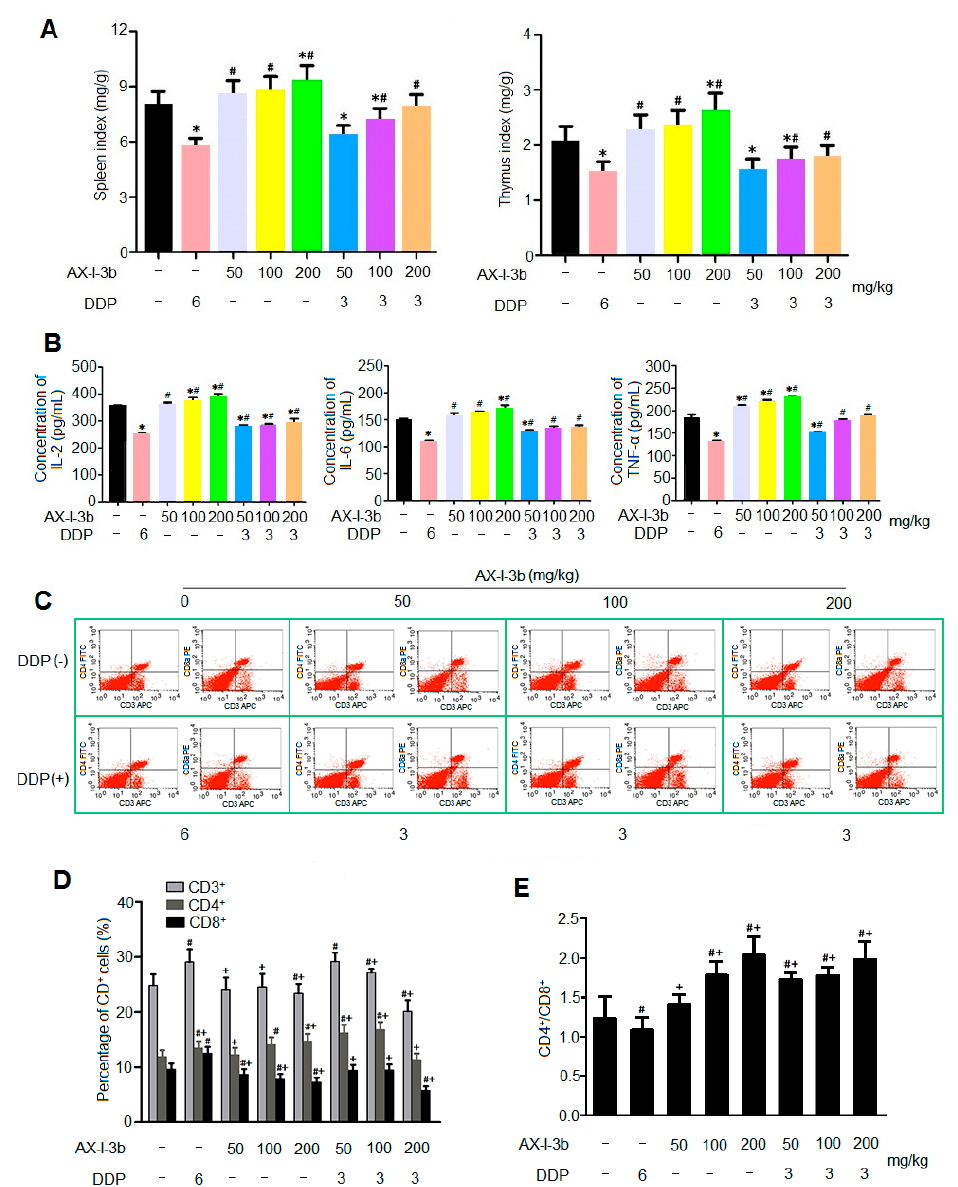
Figure 8. AX-I-3b improved immunity of Lewis lung cancer mice. ( A ) AX-I-3b increased immune organ index in Lewis lung cancer mice; ( B ) AX-I-3b increased serum cytokines levels in Lewis lung cancer mice; ( C ) Distribution of T cell subsets in the spleen of Lewis lung cancer mice by flow cytometry; ( D ) The effect of AX-I-3b on the distribution of spleen T cell subsets; (E) The effect of AX-I-3b on the CD4 + /CD8 + . * p < 0.05 compared with groups without drug treatment; # p < 0.05 compared with groups treated with DDP (6 mg/mL).